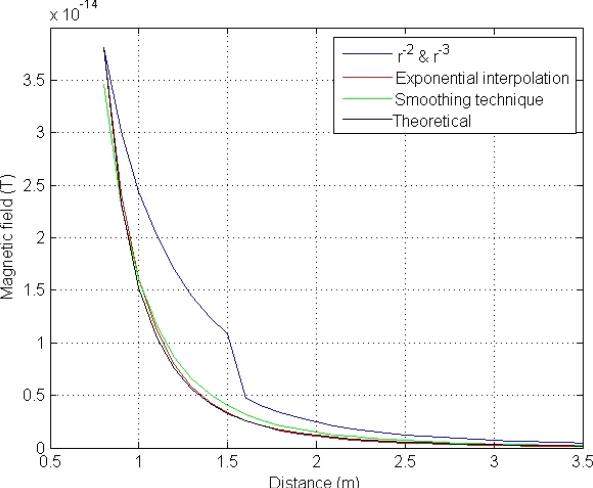
Figure 9. Magnetic field’s prediction with respect to the distance with fixed magnetometers’ location at 80 and 160cm, using several techniques (dimensions 60 × 60 × 60cm 3